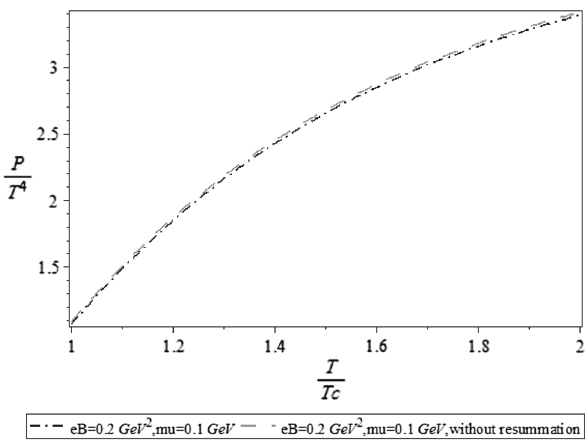
Fig. 1 The pressure P / T 4 from (20), the dash-dotted line, compared with the integral form, Eq. (21) the dashed line